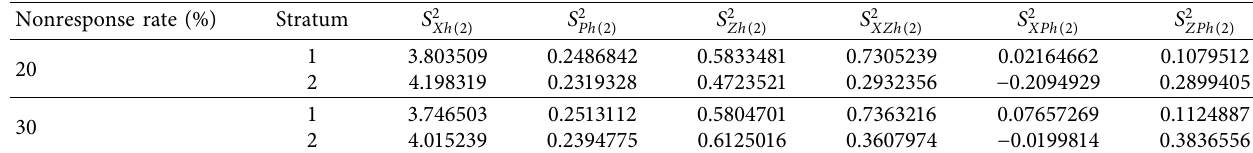
Table 4: Parameters for nonresponding units for population